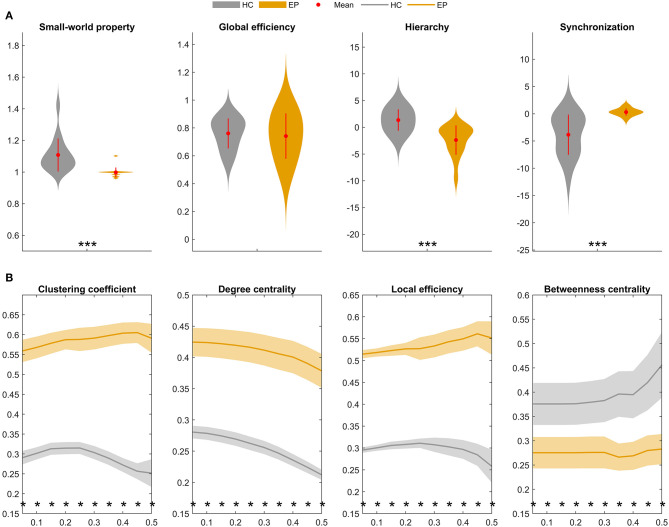
Global and local topological properties of metabolic covariance networks compared between individuals with insular epilepsy (orange) and healthy individuals (gray). (A) Between-group differences in global brain network properties displaying group means (red circles), group standard deviations (red lines), and stars (significant between-group differences). Compared to the healthy group, small-worldness (sigma, σ) was significantly reduced in the epileptic group (P < 0.01*), whereas global efficiency was not significantly different (P = 0.223). (B) Nodal brain network properties as a function of sparsity threshold (5–50%, with steps of 5%). Stars denote significant between-group differences at the respective sparsity value. The line and shading denote the mean and 95% CI of between-group differences, respectively, at each sparsity value. HC, Healthy group; EP, Epileptic group. *P < 0.05, **P < 0.01, ***P < 0.001.